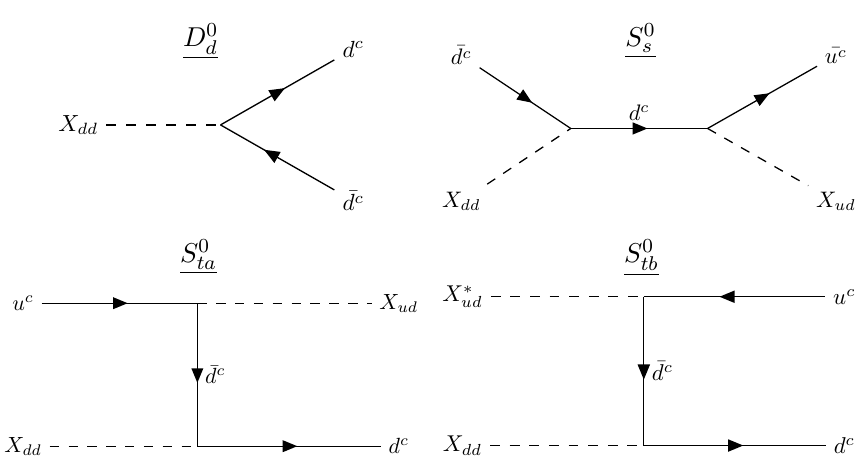
Figure 6 . Baryon number conserving scattering and decay diagrams that involve the diquarks X ud and X . The diagrams are here associated with the naming convention used in the Boltzmann dd equation, where the reverse processes are also employed.